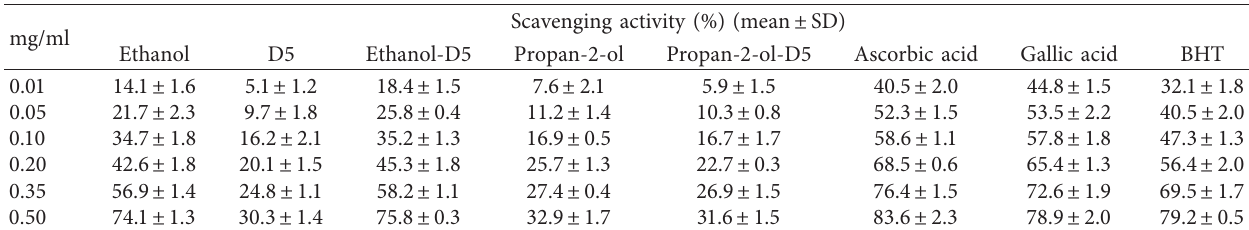
Table 6: Scavenging activity apricot cake extracts against ABTS radical at different